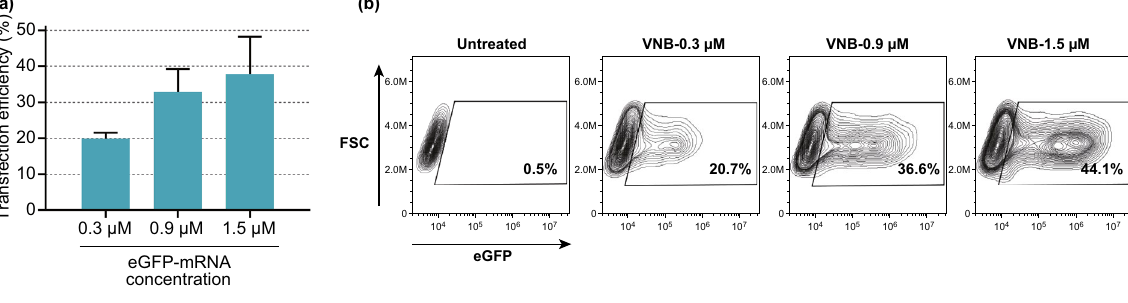
Fig. 4 Influence of increasing eGFP-mRNA concentrations on transfection efficiency. a Transfection efficiencies, expressed as the percentage eGFP-positive cells, for different concentrations of eGFP-mRNA ( n = 3). b Contour plots of a representative experiment on HeLa cells trans- fected with increasing concentrations of